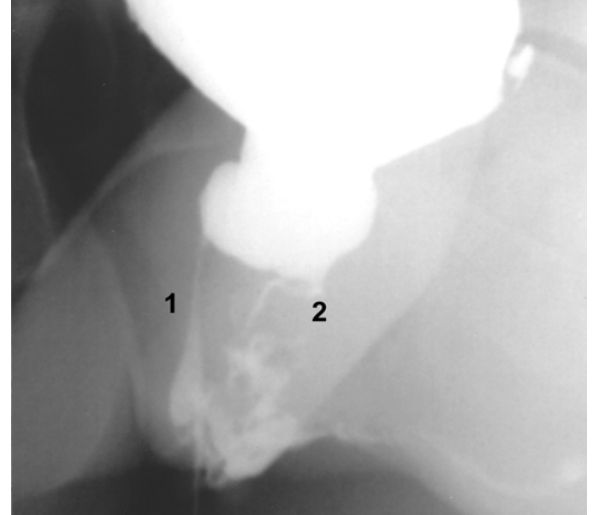
Figure 2 – Voiding cystography. On the left is evident accessory urethra distally ending in a cul-de-sac close to perineum [1]. A kinking of the primary urethra with a severe prestenotic dilata- tion is also evident